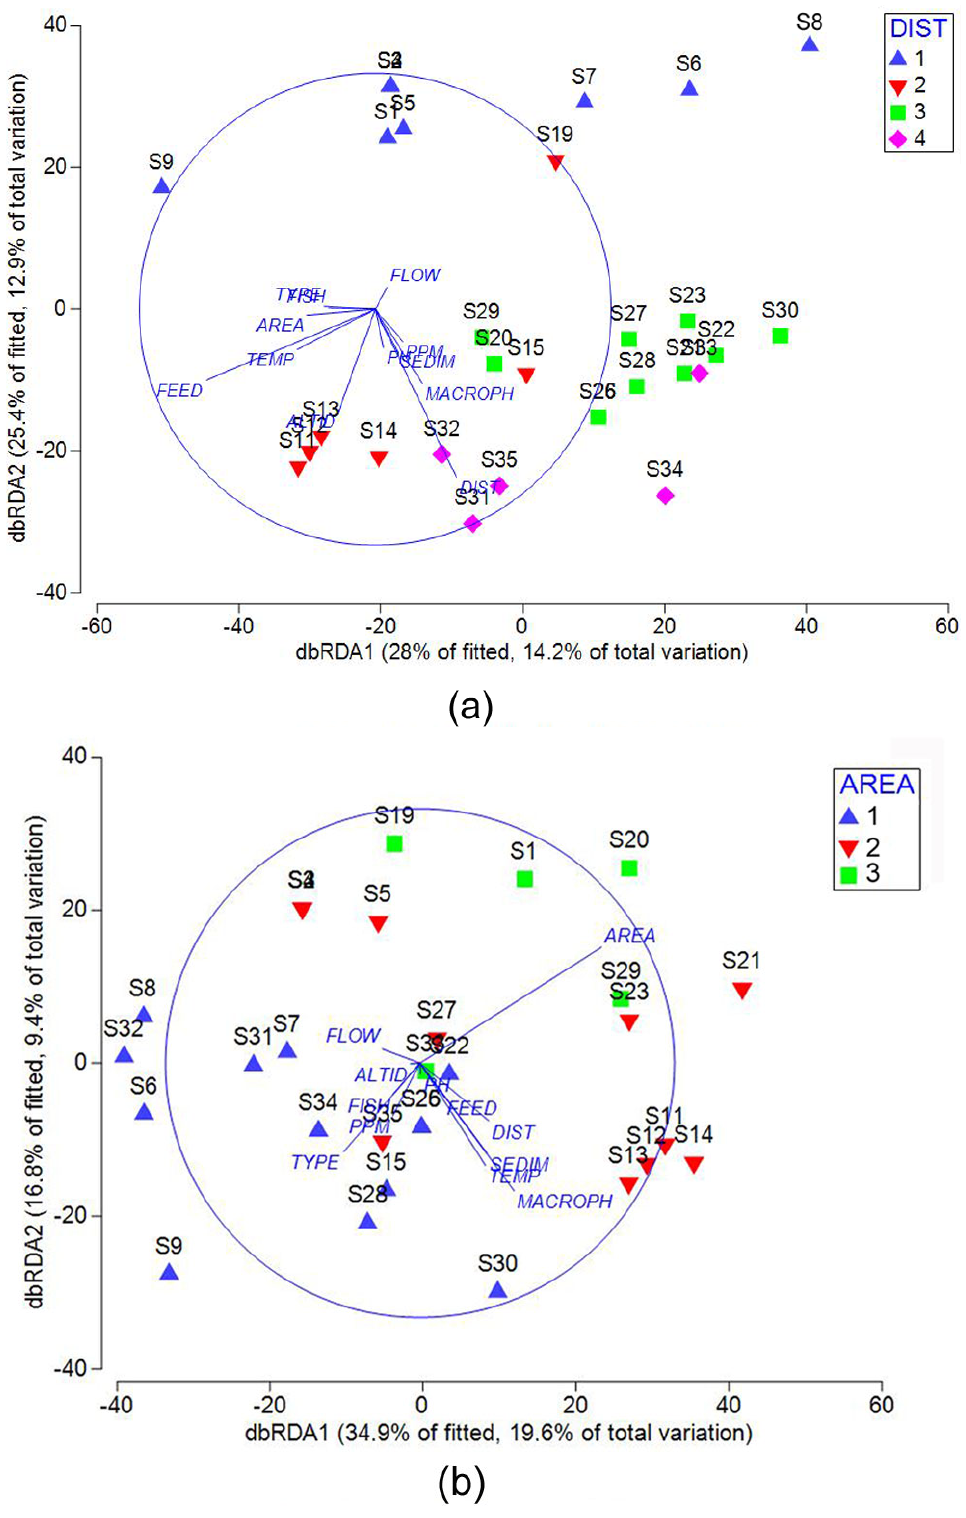
Figure 3. dbRDA ordination of microcrustacean assemblages from the Putorana Plateau. ( a ) Meio- fauna assemblages factored with different districts: 1—central part (Ayan Lake basin and Neral River valley); western slopes: 2—Burgul River valley, 3—Kutaramakan Lake basin and Irkinda River valley; 3—foothills (Keta Lake basin); ( b ) Zooplankton assemblages factored with different waterbodies sizes: 1—0.0001–0.009 km 2 ; 2—0.01–0.05 km 2 , 3—0.15–7.7 km 2